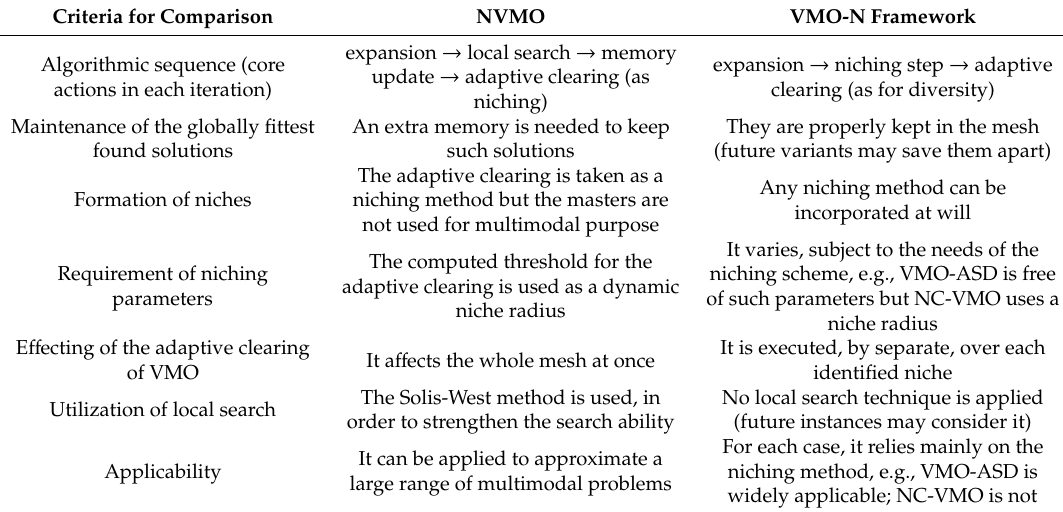
Table 1. Major di ff erences between VMO-N and NVMO.